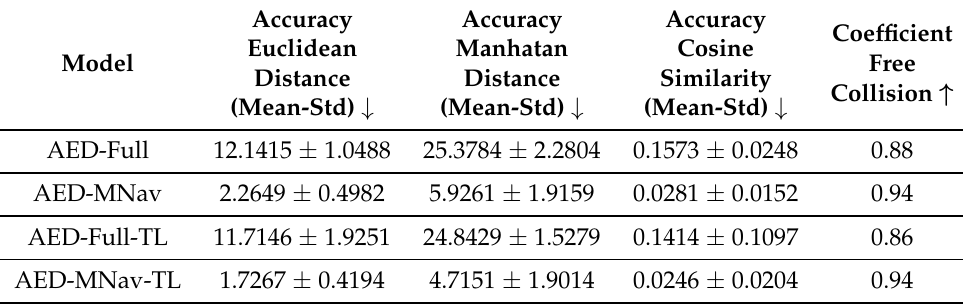
Table 7. Performance about transfer learning approach and its standard deviation in 50 samples. Where ↓ Low is better, and ↑ Up is better. AED-Full (auto-encoder with full path), AED-MNav